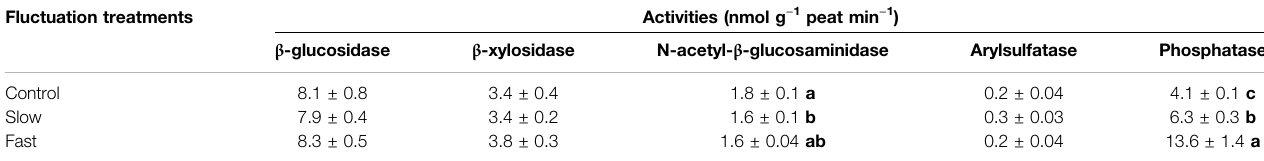
TABLE 2 | Activities of extracellular enzymes in peat. Letter denotes statistically signi fi cant differences between treatments (n (cid:2) 12, p < 0.05).